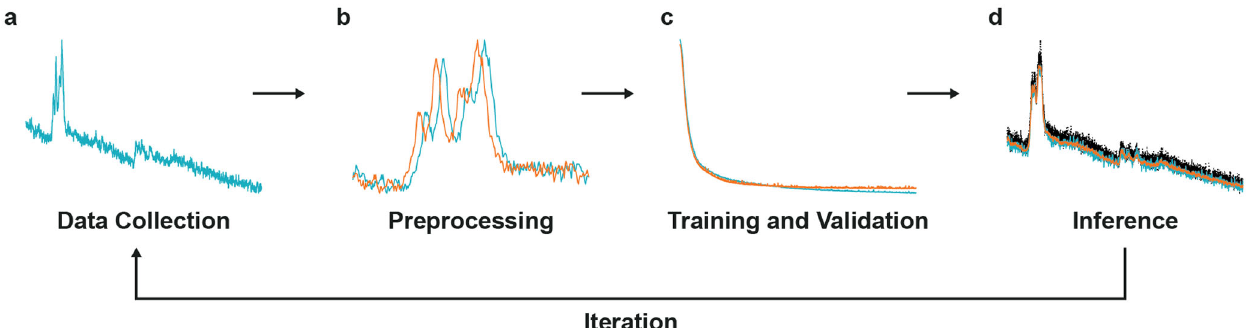
Fig. 1 Overview of the EELSTM model work fl ow. a – d Steps include data collection, preprocessing, training and validation, and inference,